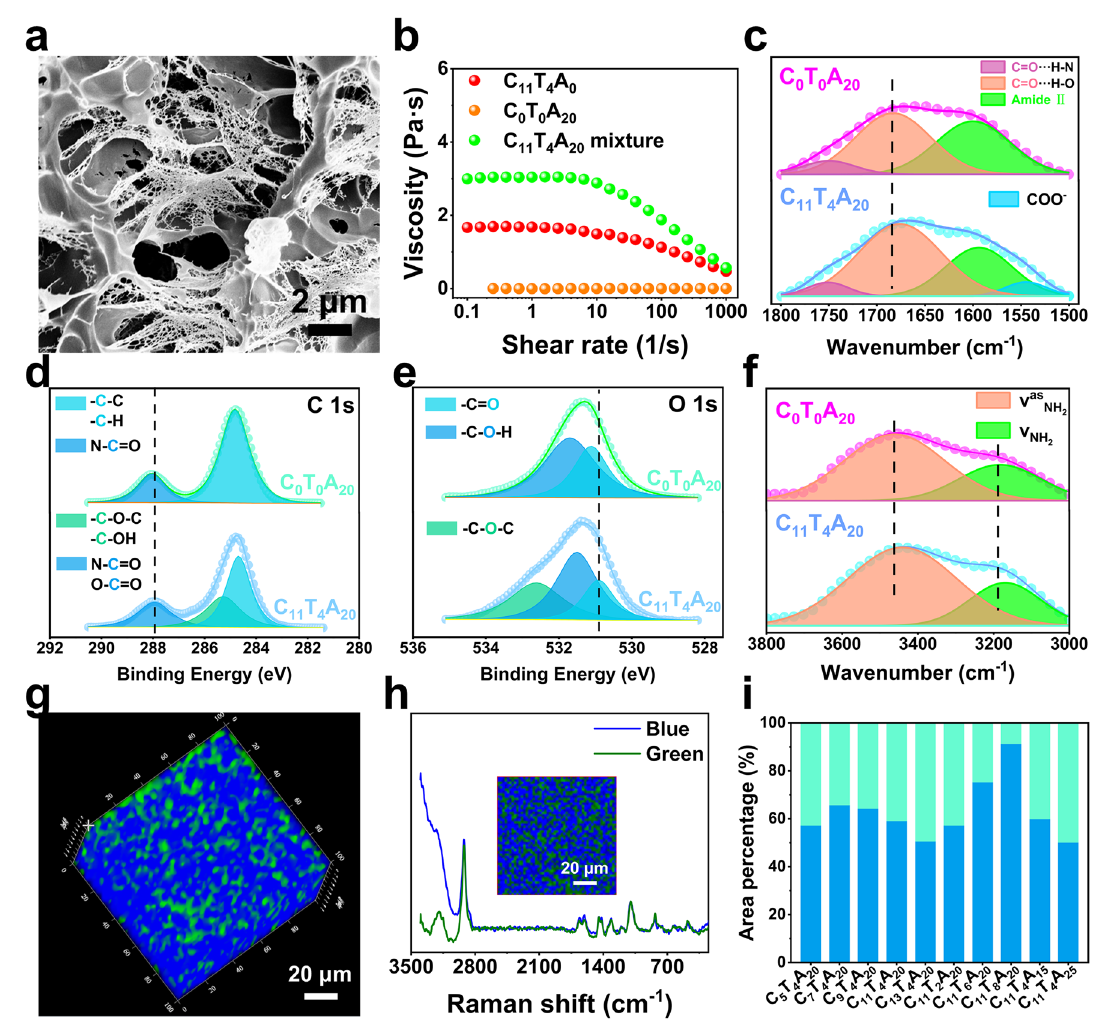
Fig. 2 a SEM images of the C 11 T 4 A 20 hydrogel. b The viscosity versus shear rate of C 11 T 4 A 0 , C 0 T 0 A 20 and C 11 T 4 A 20 mixture. c FT-IR spectra (1500–1800 cm −1 ) of